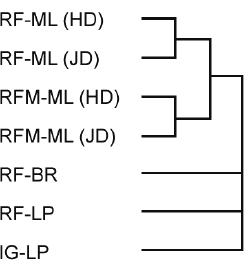
Figure 6: Illustration of the experimental setting re- garding this